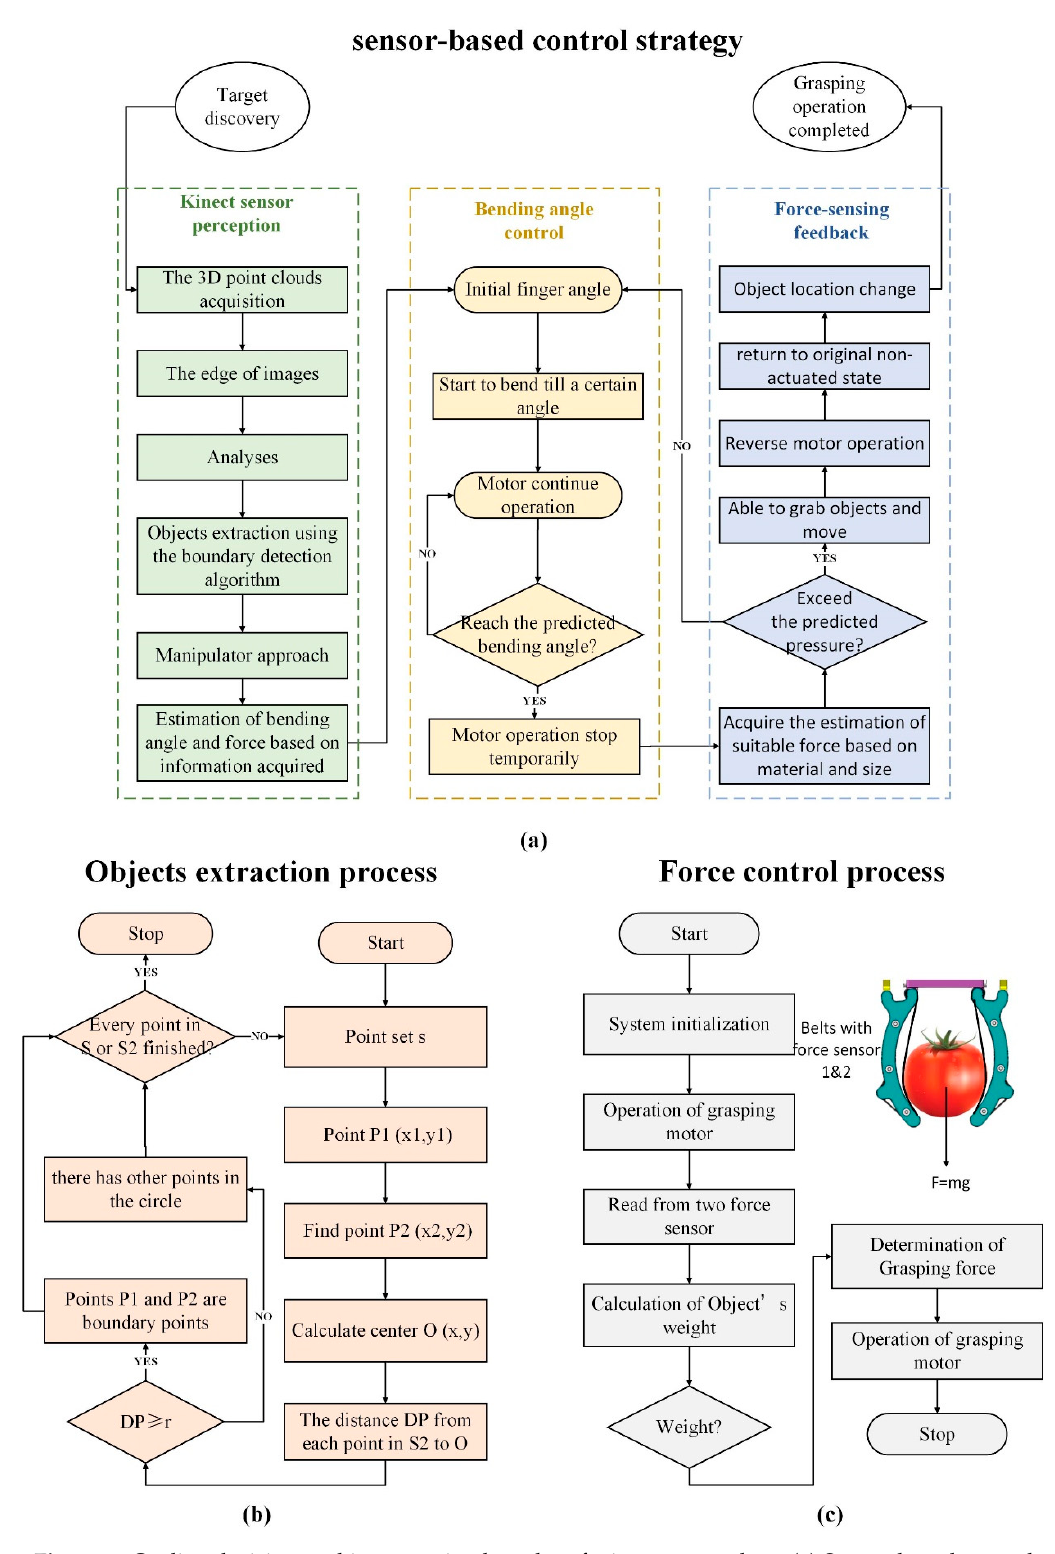
Figure 5. On-line decision-making grasping based on fusion sensory data. ( a ) Sensor-based control strategy. ( b ) Primitive shape extraction from point cloud. ( c ) Force control process.